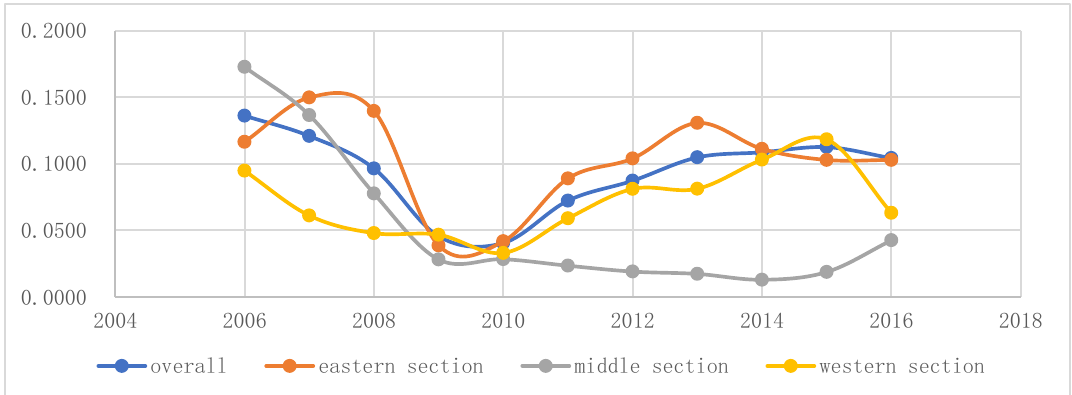
Figure 1. Variation-coefficient trend diagram of the overall, eastern, middle, and western sections of water utilization efficiency in the Yangtze River Economic Belt.